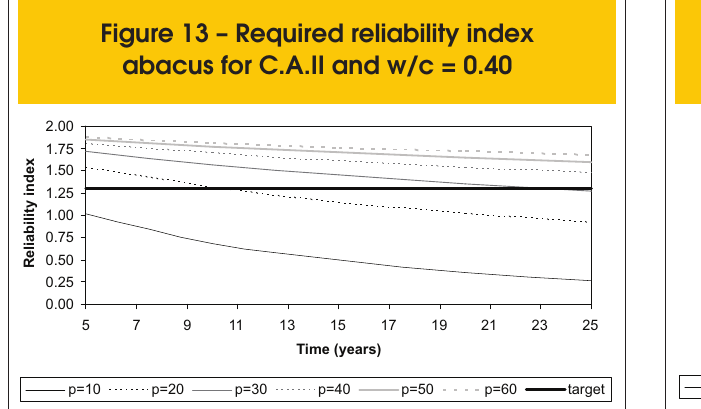
Figure 14 – Required reliability index abacus for C.A.II and w/c =